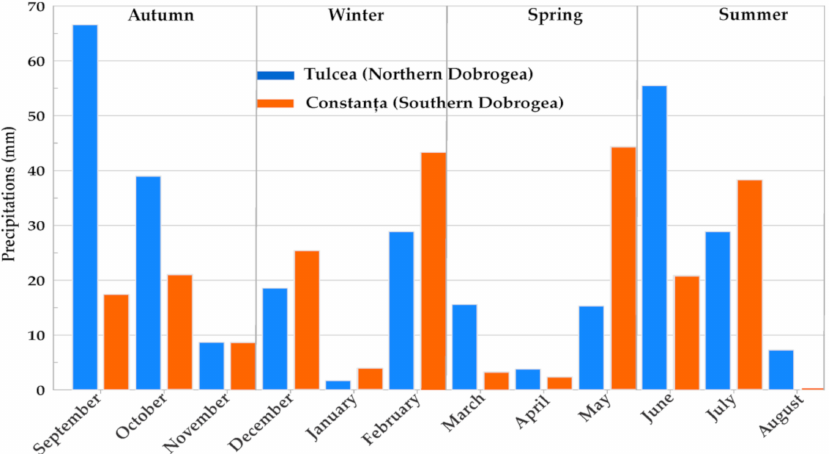
Figure 3. Monthly average precipitation in Northern and Southern Dobrogea (Tulcea and Constanta meteorological stations) between September 2019 and August 2020.